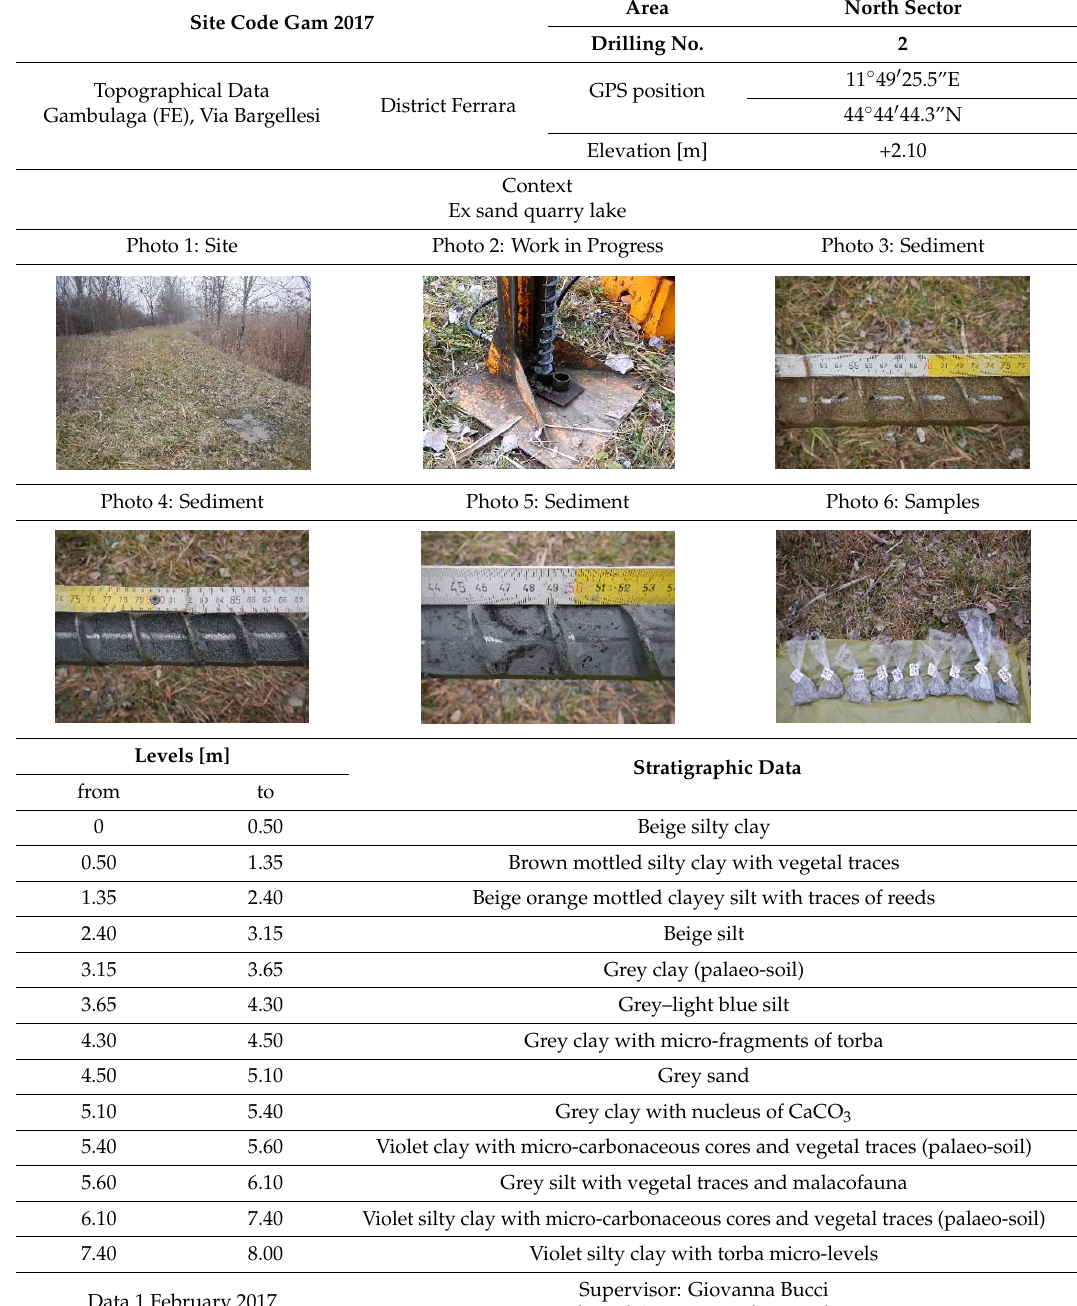
Figure A2. Graphic depiction of drilling No. 2 in 2017 in Lago Tramonto, Gambulaga, Portomaggiore